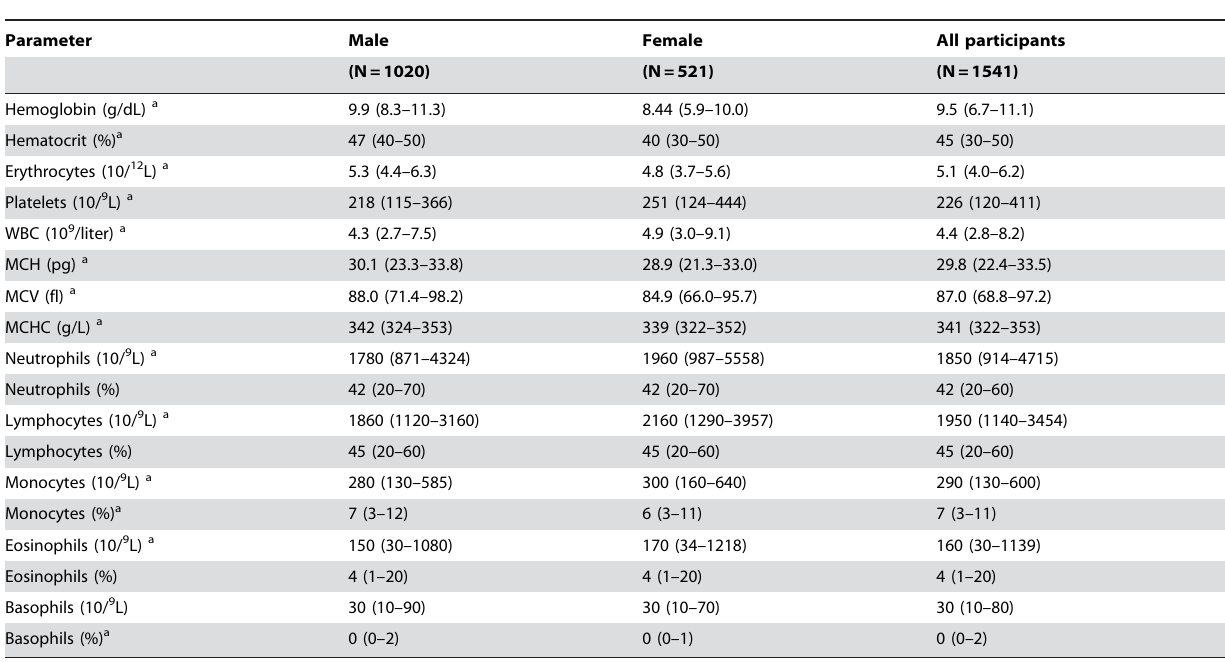
Table 2. Hematology reference ranges (median and 95th-percentile) derived from HIV-seronegative adults in Kericho, Kenya.